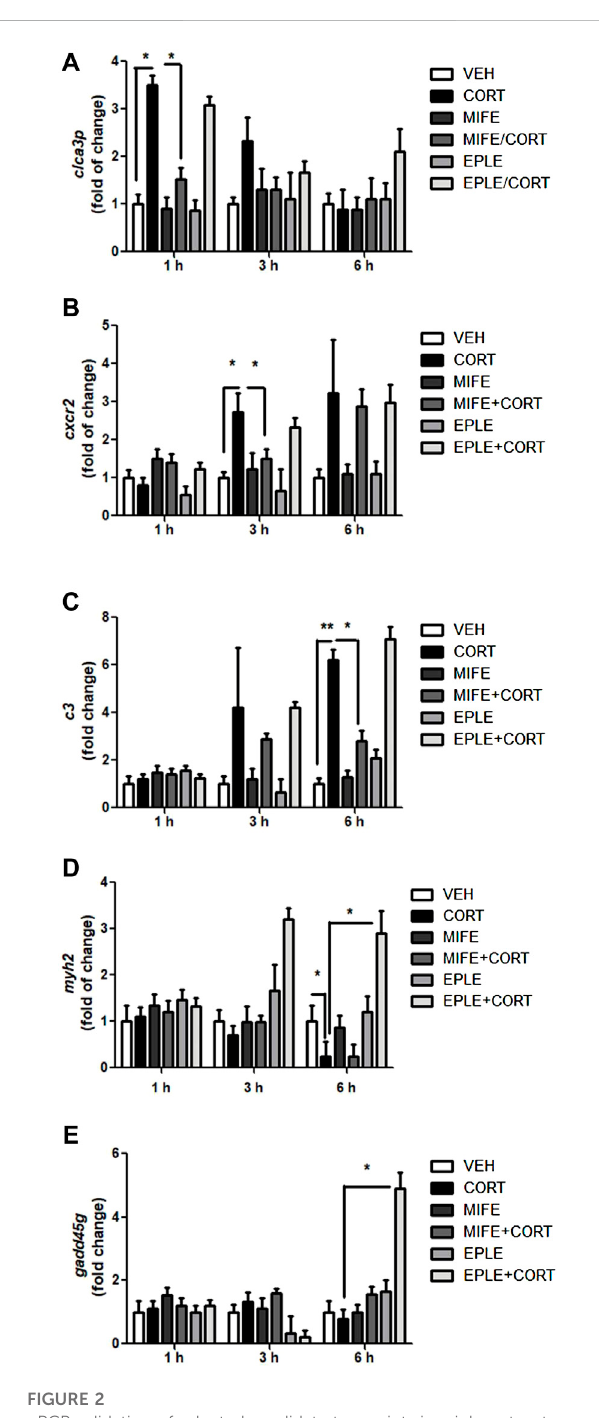
FIGURE 2 qPCR validation of selected candidate transcripts in rainbow trout myotubes. (A – E) cxcr2 , c3 , clca3p , myh2 , gadd45g expression in rainbow trout myotubesstimulated with cortisol (CORT)in